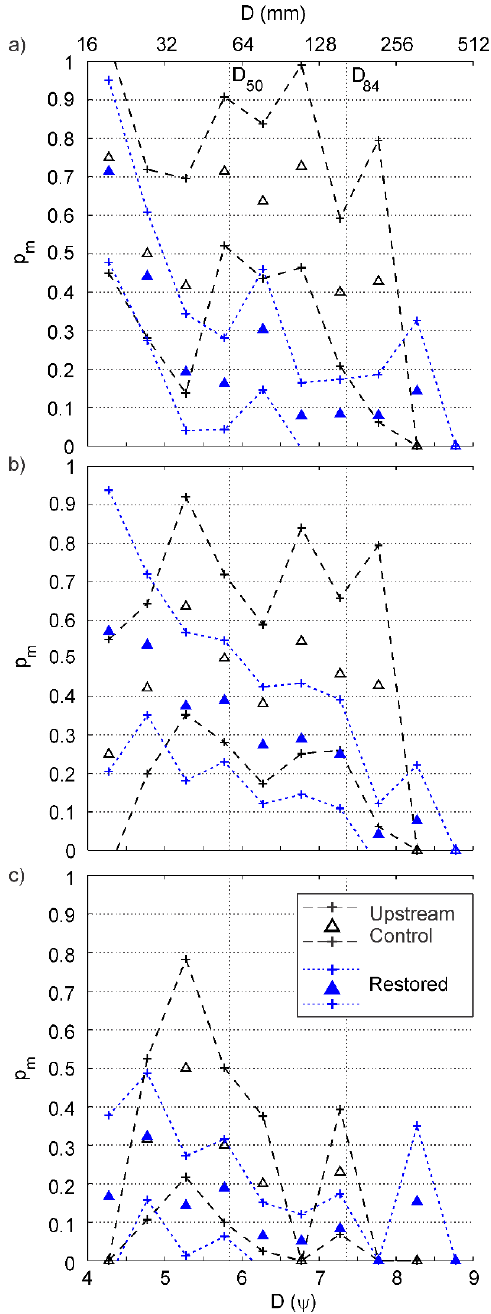
Figure 9. Mobility for upstream control and restored for time periods: ( a ) August 2013– May 2014; ( b ) May 2014–July 2014; and ( c ) July 2014–August 2014. 95% confidence intervals are shown as dashed and dotted lines for the upstream control and restored reach,